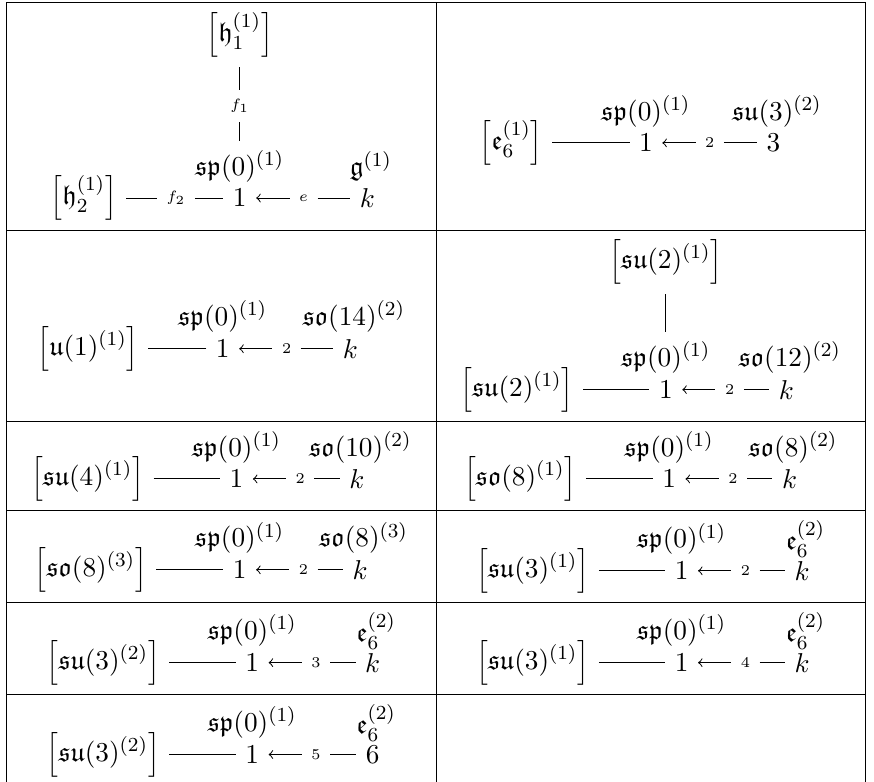
Table 11 . Possible localized flavor symmetries in 5 d KK theories for nodes with a trivial gauge algebra having incoming directed edges. See text for explanation of first entry in the table. Con- tinued in table